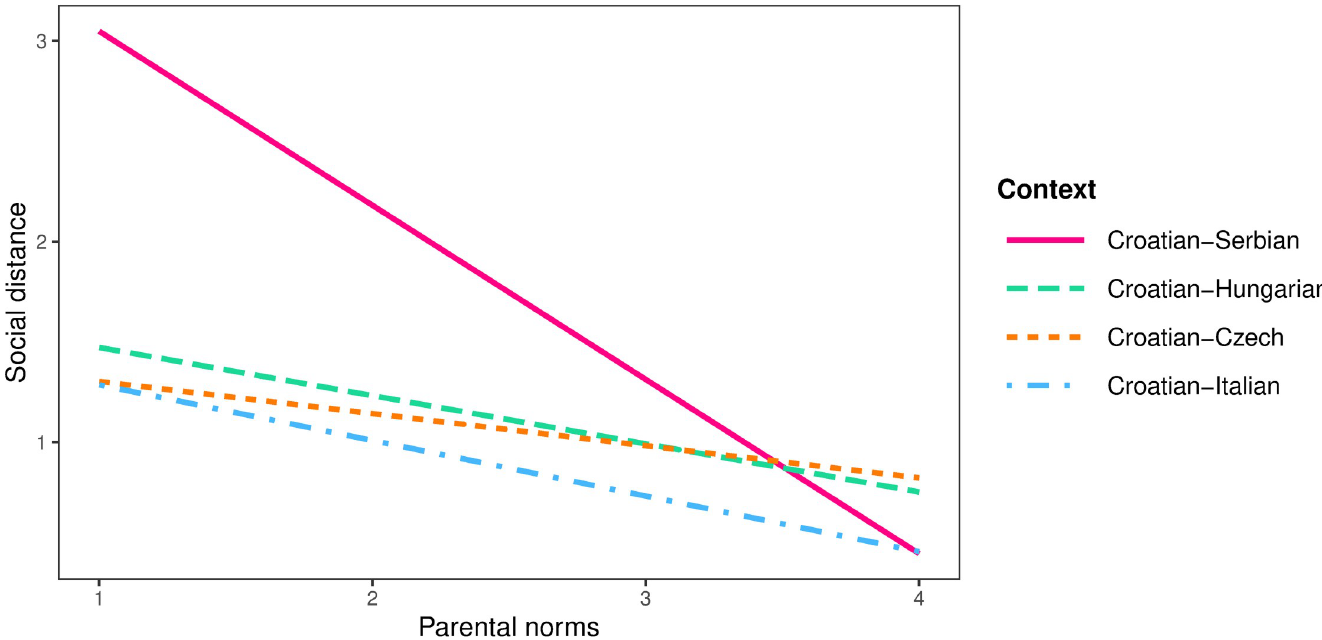
Fig 8. Interaction plot between parental norms and intergroup context on social distance.